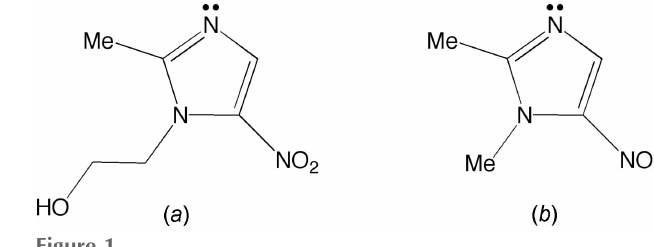
Figure 1 A comparison of the structures of ( a ) metronidazole (MET) and ( b ) dimetridazole